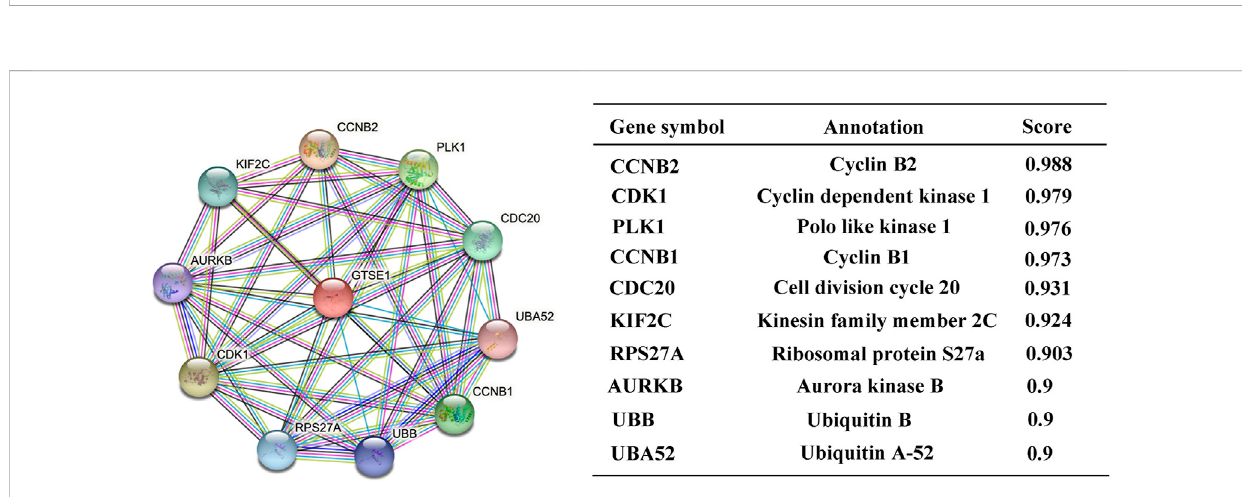
p = 4.99e − 13), but negatively correlated with tumor purity (Supplementary Figure S4). Meanwhile, the “ CIBERSORT ” algorithm was used to estimate the relative in fi ltration proportion of 22 immune cell types in the GTSE1 high- and low-expression groups in ccRCC (cutoff by the median